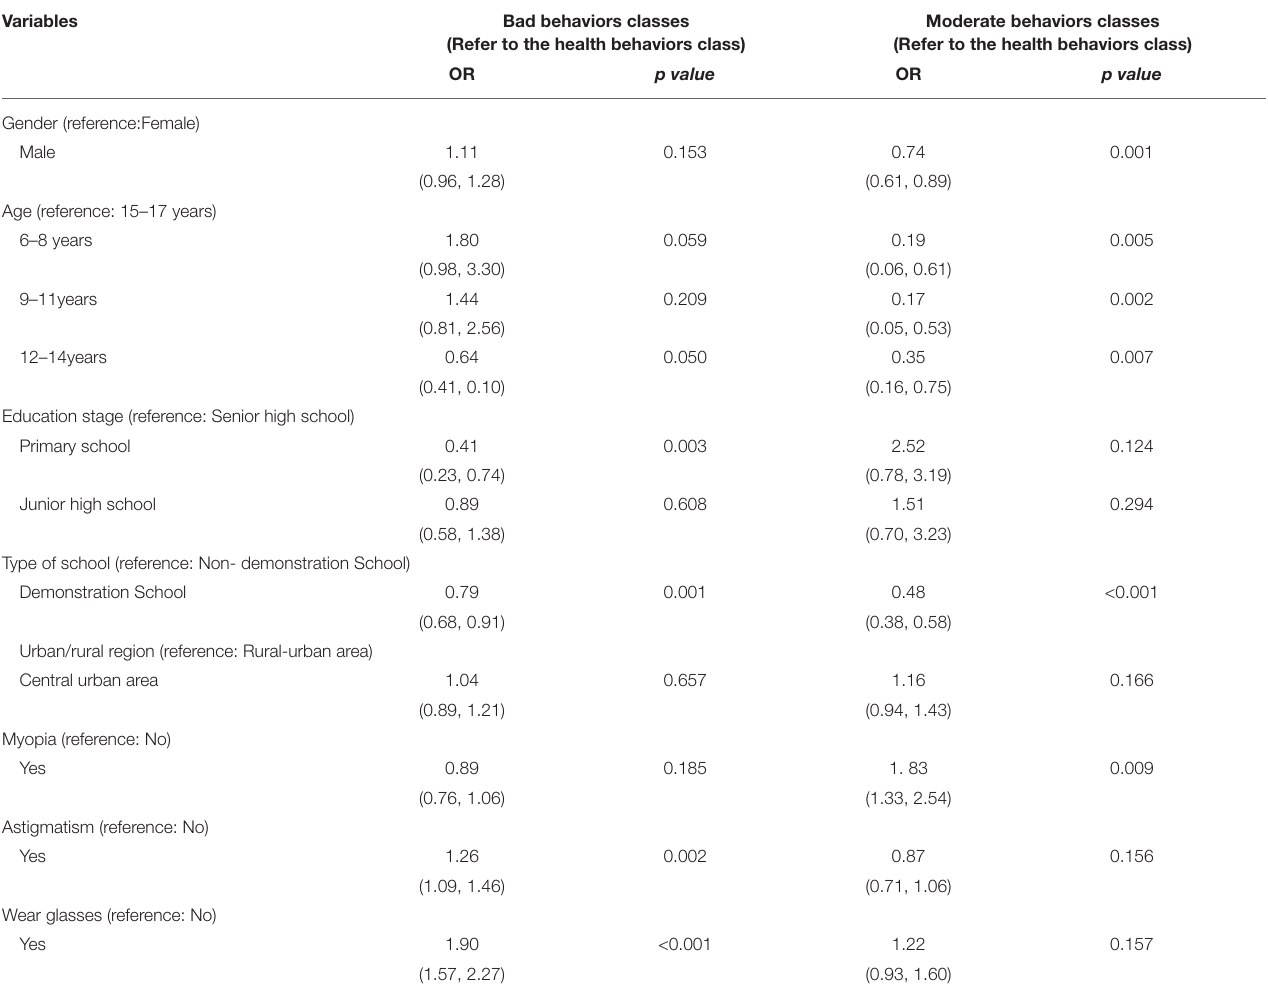
TABLE 7 | Results of a regressive mixed analysis of adolescent eye care behavior. Variables Bad behaviors classes